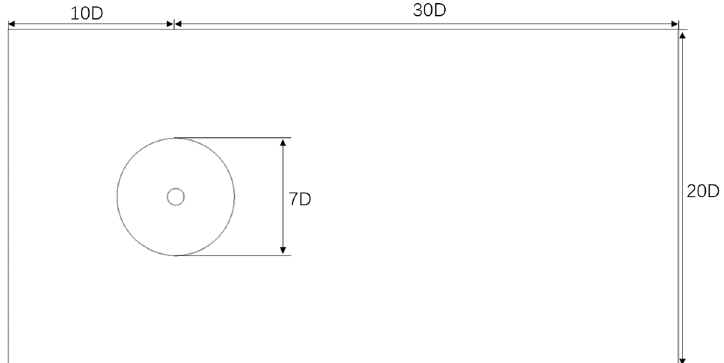
Figure 3. Calculation area.